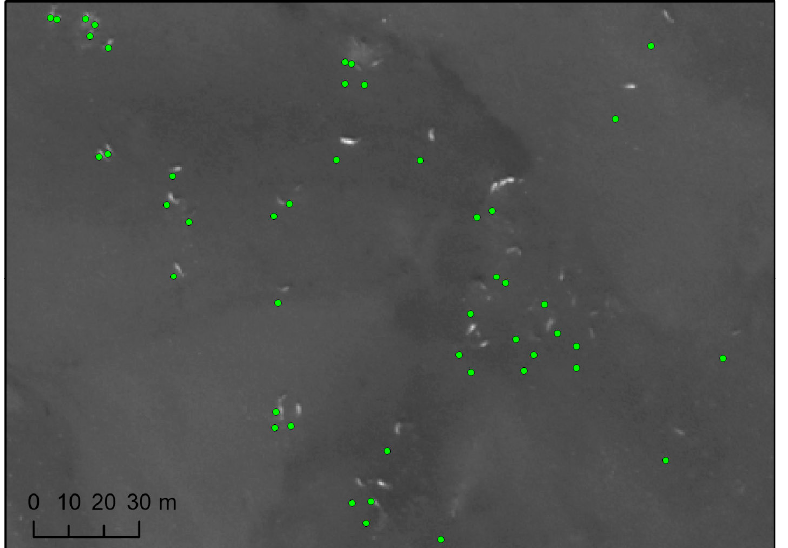
Figure 14. Example of annotation misalignment due to image processing despite obtaining the same Catalog ID and image product (Catalog ID: 103001000CD56600, WorldView-3, Standard 2A product). The green point annotations are shifted rather than being centered on each animal as they were when the image was originally annotated. Satellite images © 2023 Maxar Technologies.